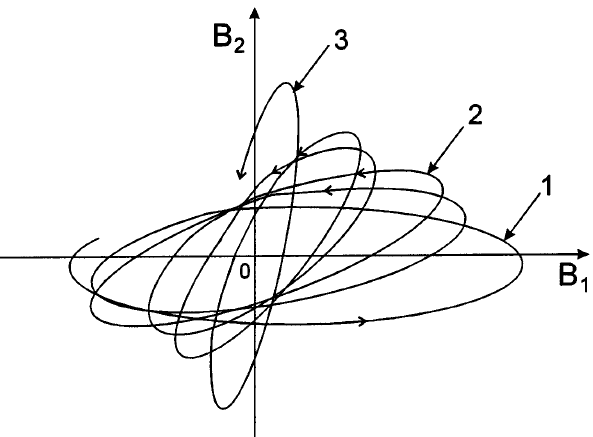
Fig. 2. Hodographs of non-stationary Alfve´ n oscillations with m (cid:29) 1 excited by a source of the type of ‘‘instantaneous impulse’’ at